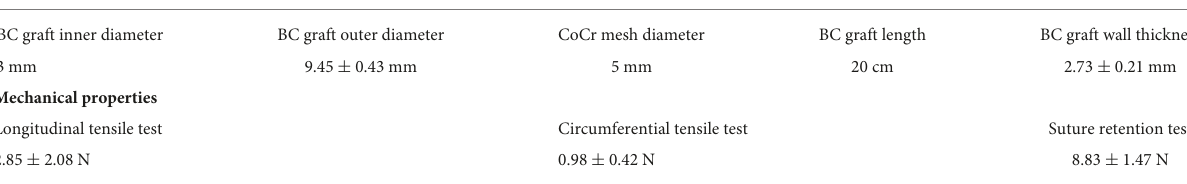
TABLE 1 Bacterial cellulose (BC)-vascular graft morphological and mechanical features ( n = 3). Morphological